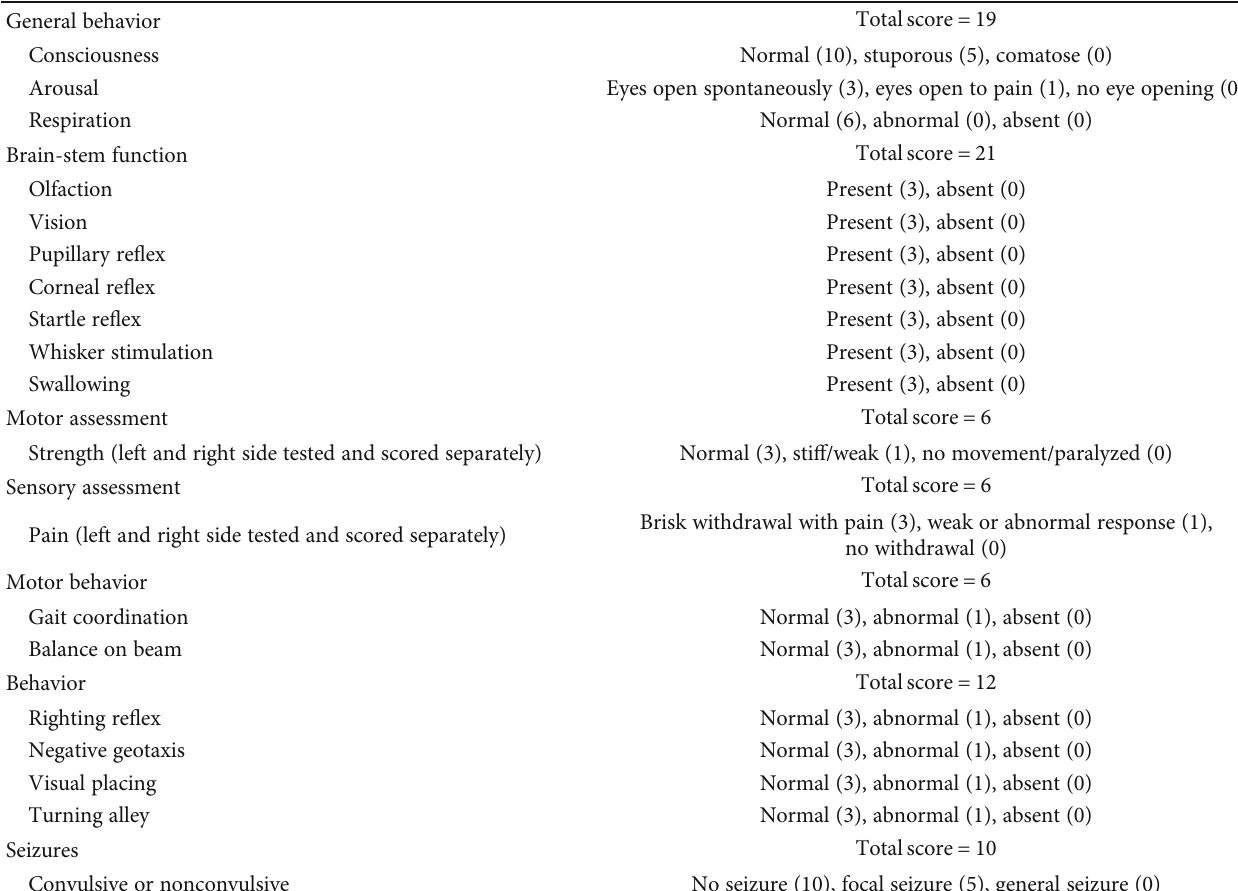
Table 1: Neurological de fi cit scores (NDS) for